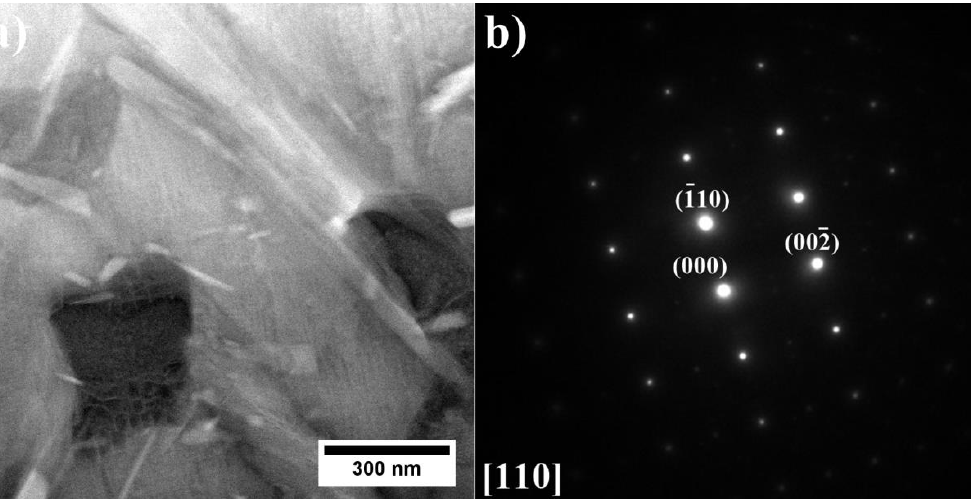
Figure 18. ( a ) Morphology of the α -Cr precipitates; ( b ) SAED pattern of the α -Cr precipitate, STEM-HAADF.